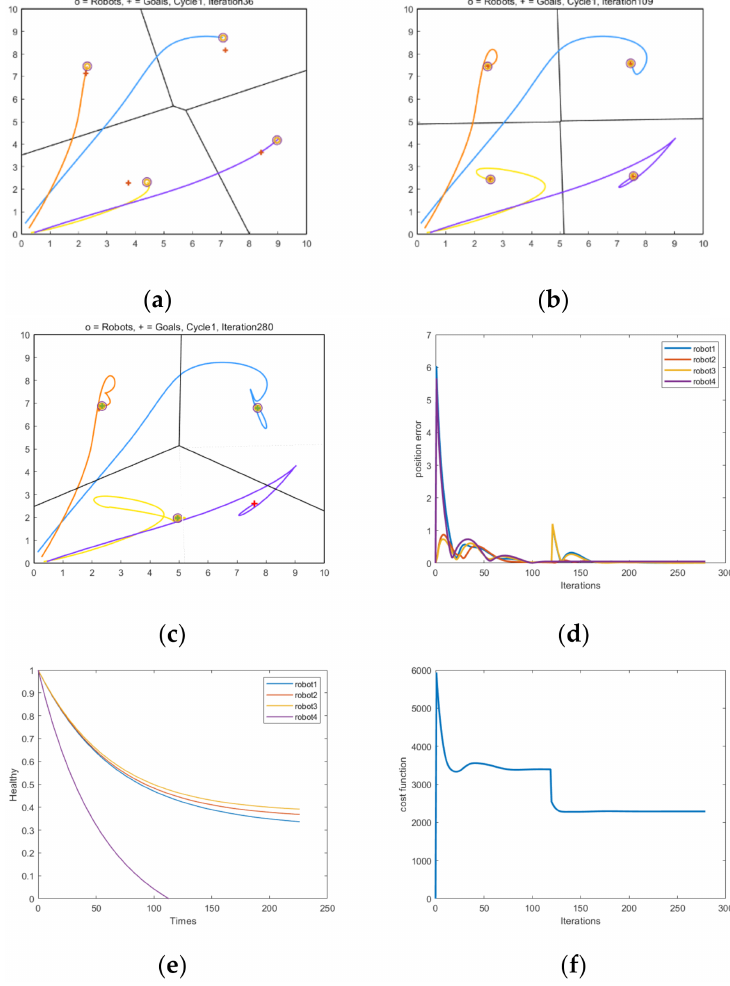
Figure 15. Robot formation after the introduction of the insert construction method: ( a ) k = 36; ( b ) k = 109; ( c ) k = 280; ( d ) position error; ( e ) h i ( t ) of each robot; ( f ) cost